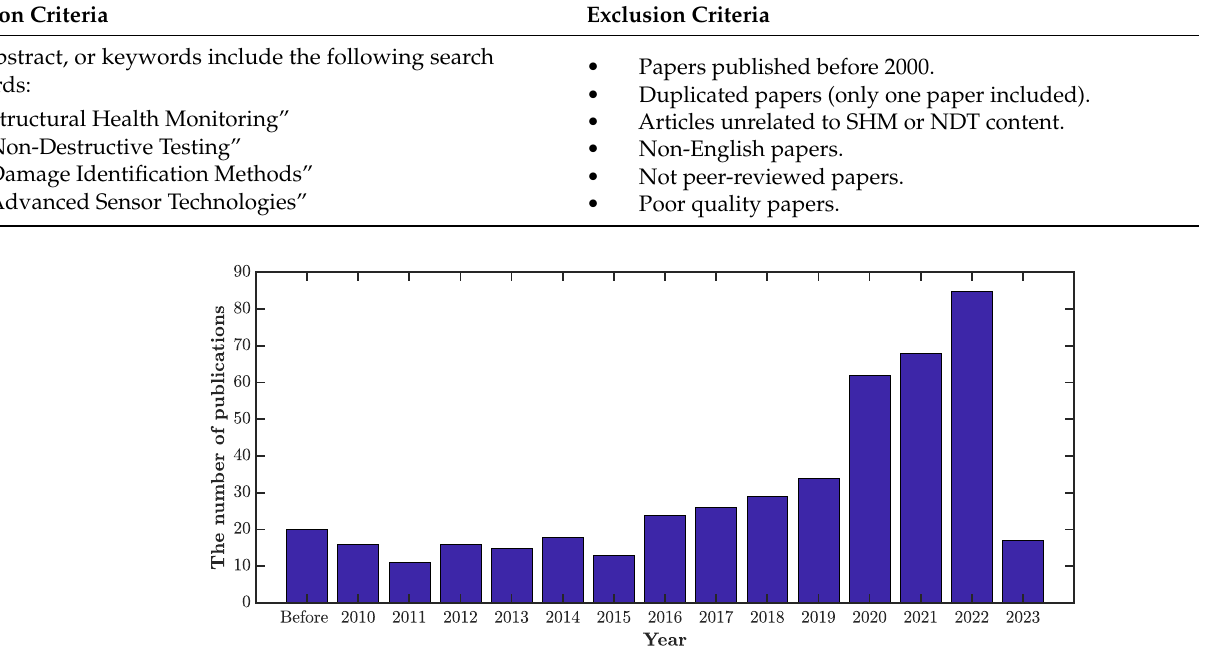
Figure 2. Number of selected and reviewed articles by